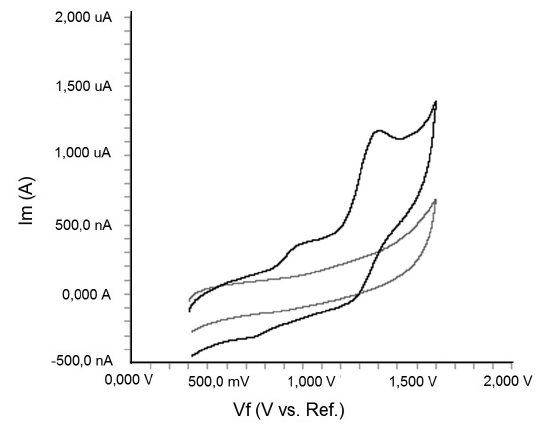
FIGURE 2 - Cyclic voltammogram for the oxidation of 20 μg mL -1 diclofenac in acetonitrile containing 0.1 M TBAClO at Pt disk electrode, scan rate: 0.2 V s -1 .